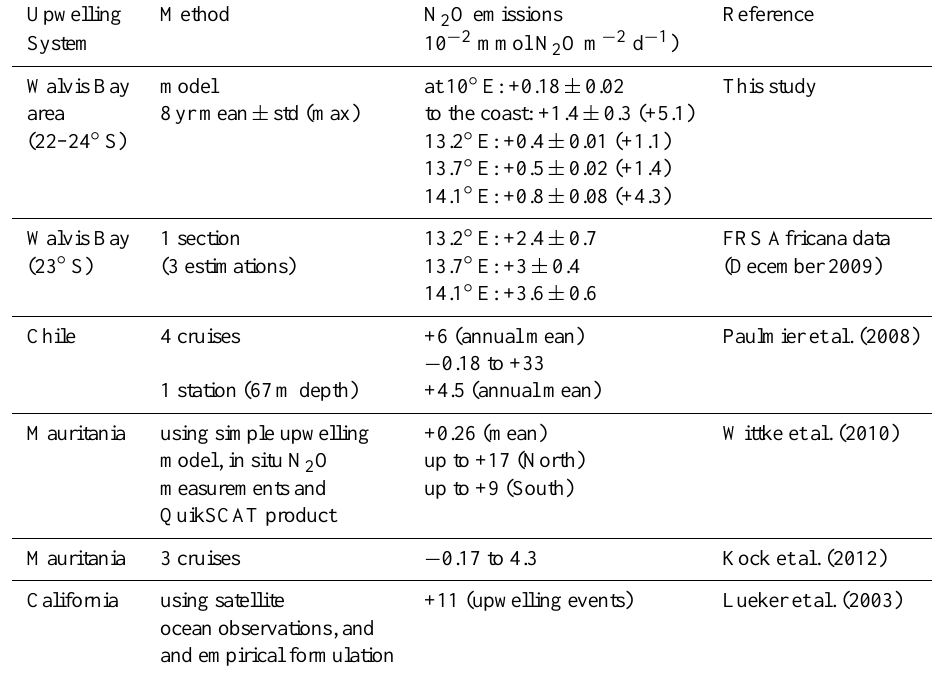
Table 3. N 2 O emissions to the atmosphere (10 − 2 mmolN 2 Om − 2 d − 1 ) estimated in EBUS using the atmospheric convention (positive flux means an outgassing of N 2 O from the ocean to the atmosphere).